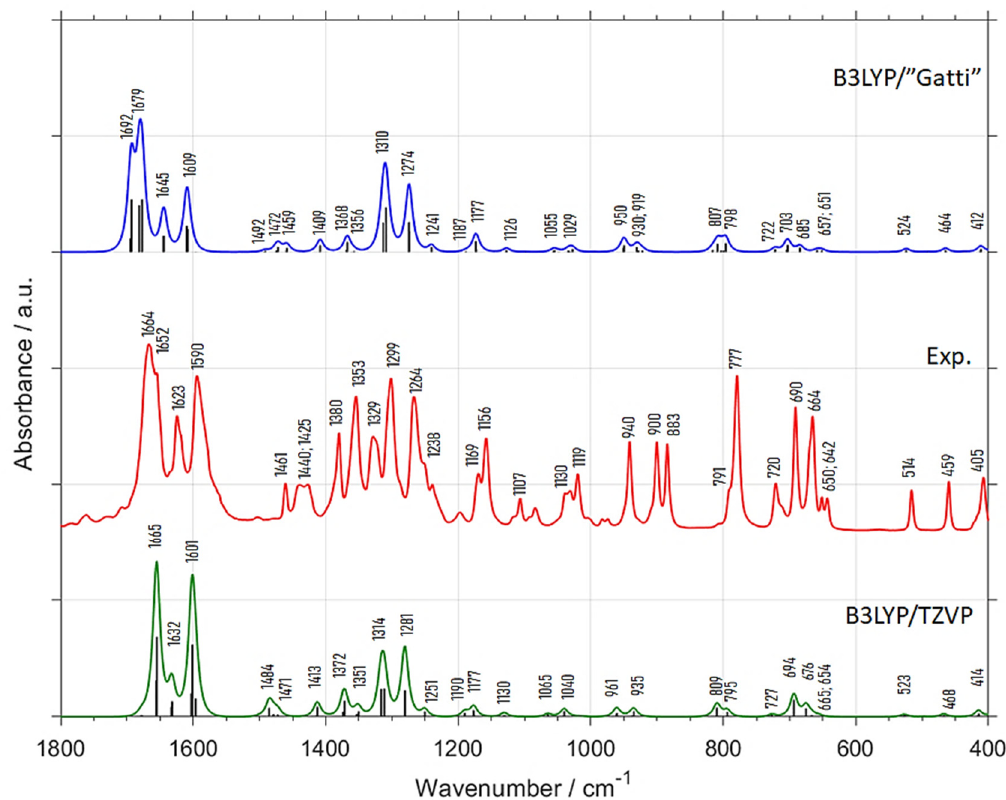
Figure 1. Spectrum of crystalline menadione in the 1800–400 cm − 1 range together with the harmonic spectra calculated by periodic DFT (B3LYP/”Gatti” and B3LYP/TZVP). The detailed band assignments are presented in Table 1. Table 1. Experimental and calculated band positions [cm − 1 ] together with calculated relative intensities [%] and assignments of the fundamental bands in the 1800–400 cm − 1 range for crystalline menadione. Experimental Position (int.) (a)